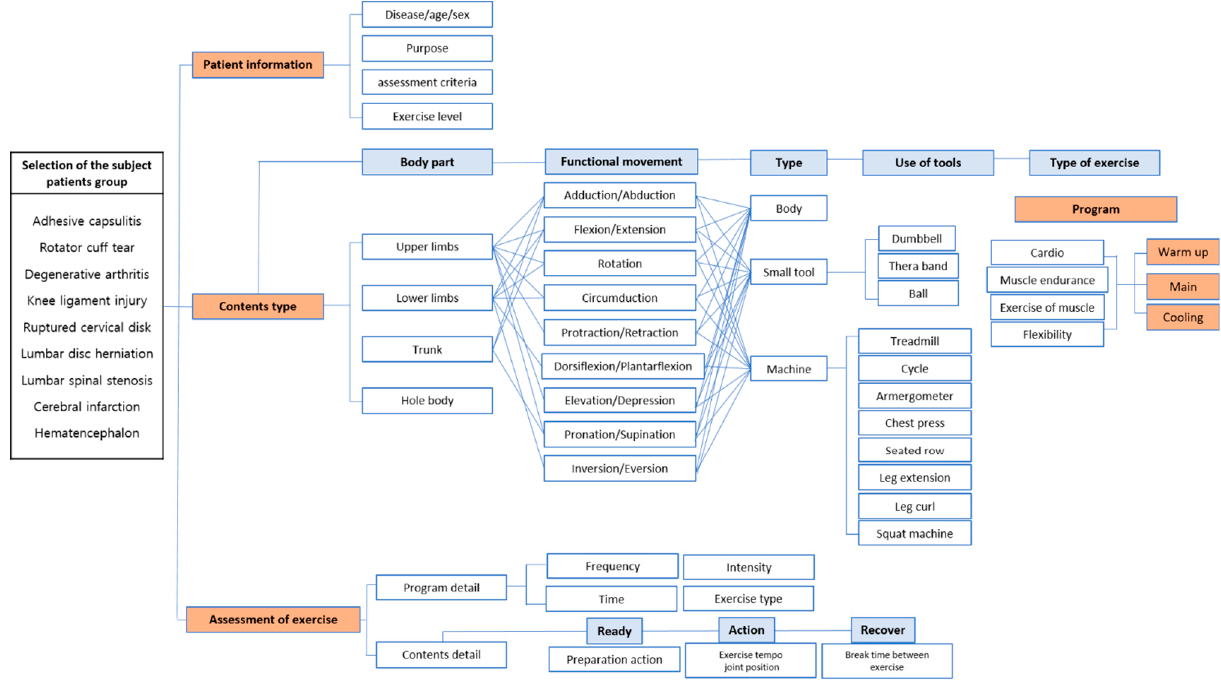
Figure 3. Exercise rehabilitation service model